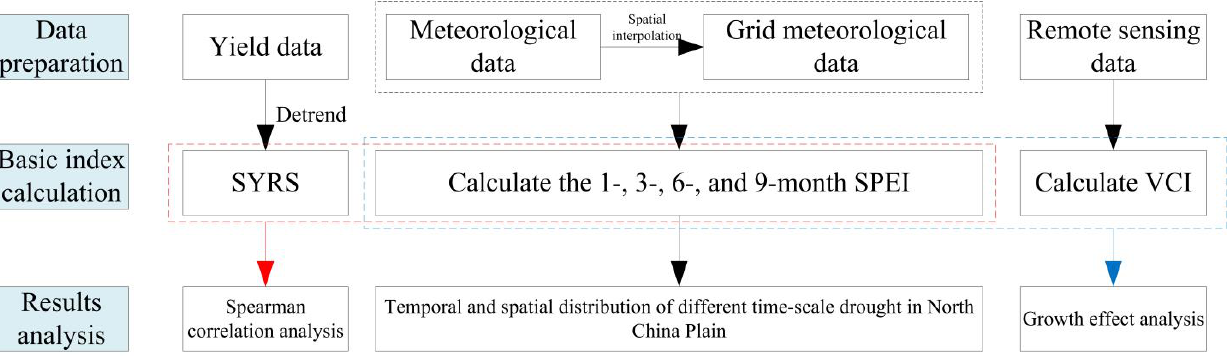
Figure 2. Methodological framework of this paper.